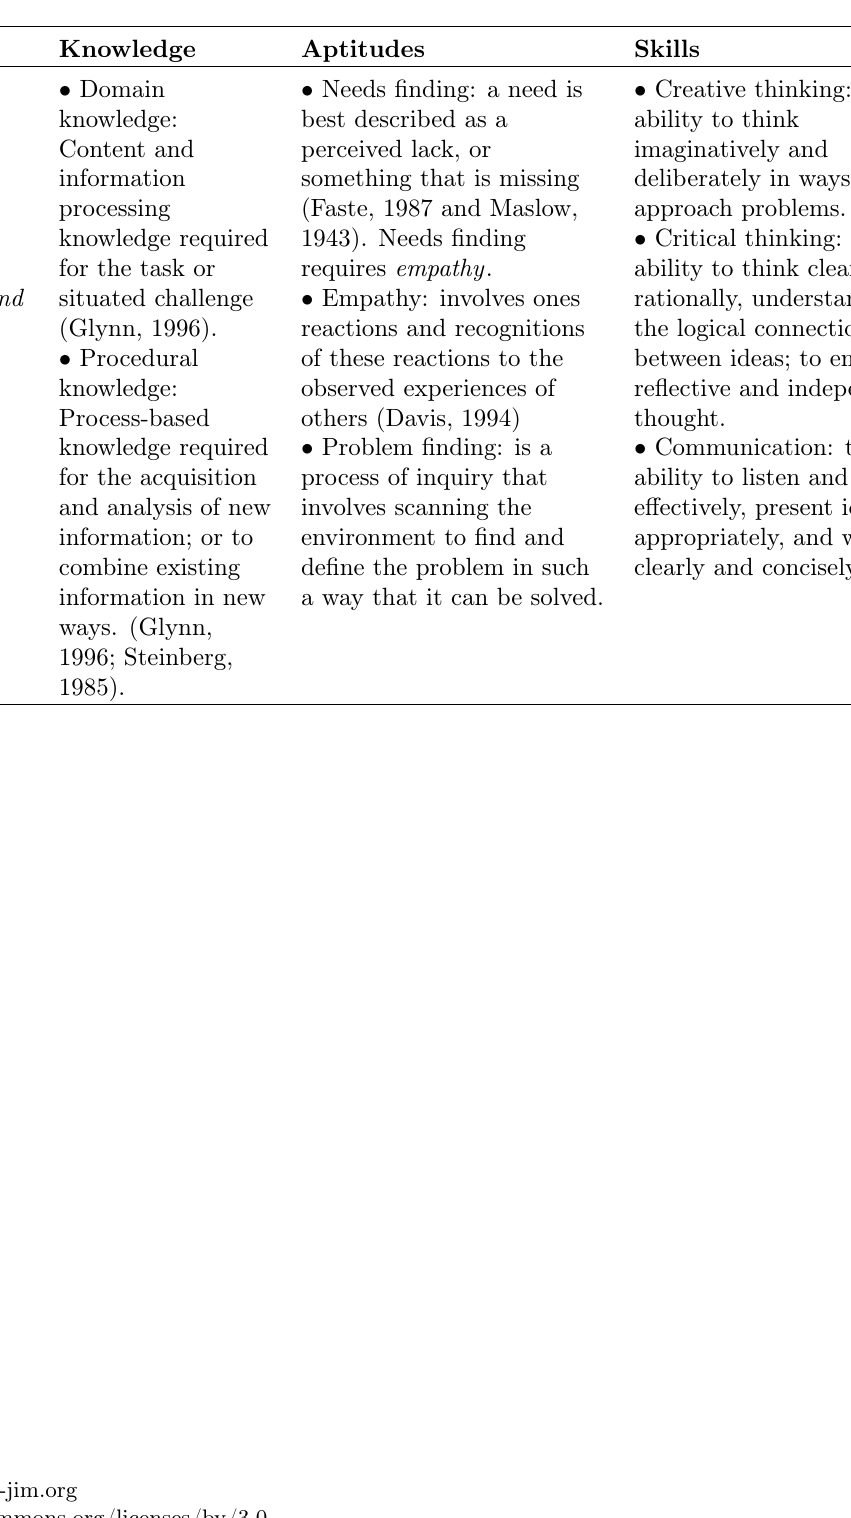
Table 3. Proposed innovative competencies framework based on Rogers’ IDP Rogers’